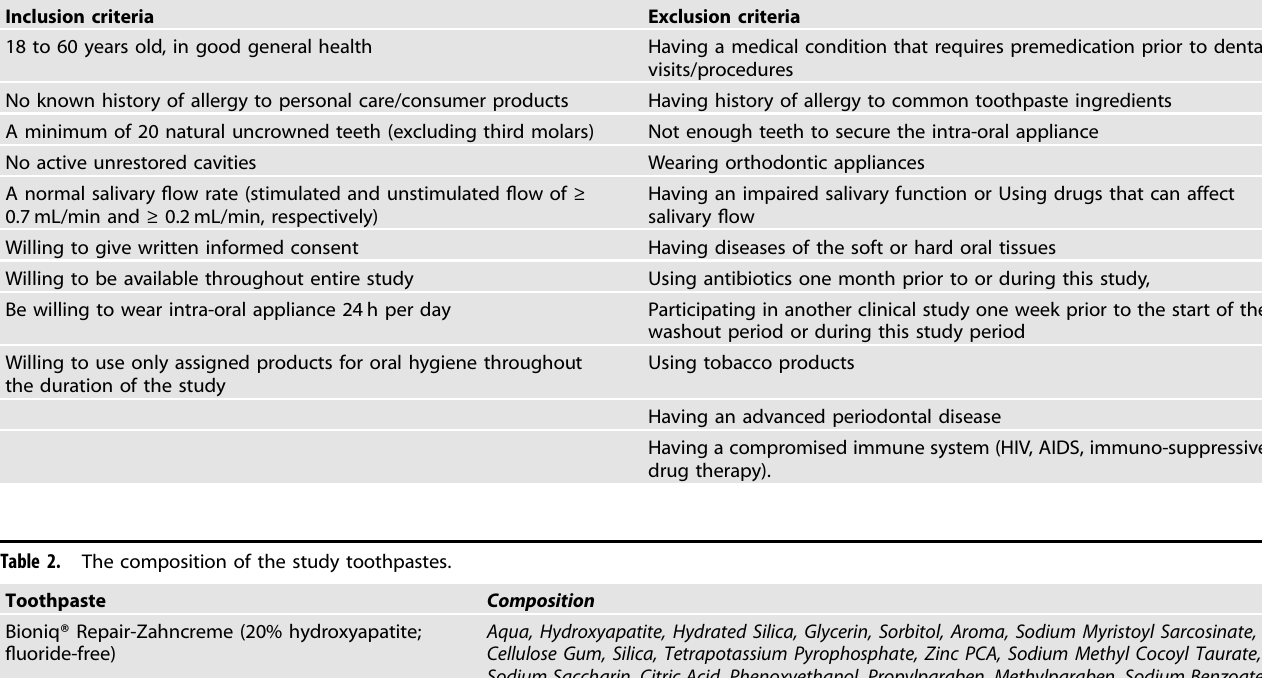
Table 1. List of inclusion and exclusion criteria.